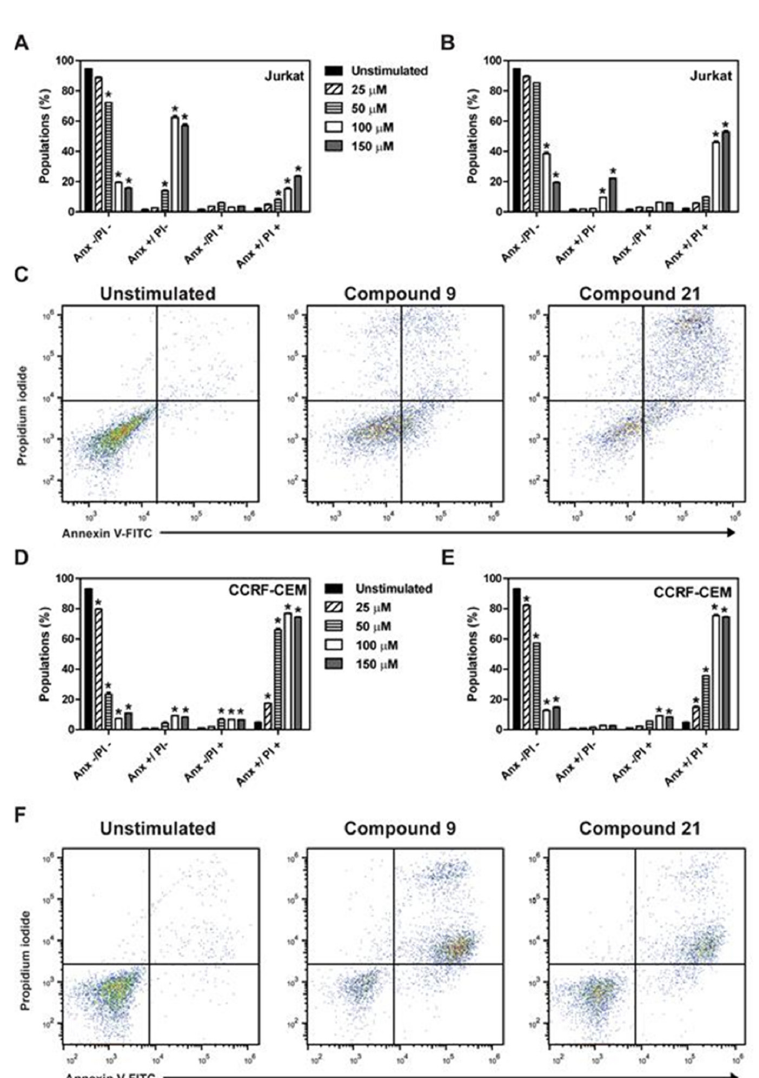
Figure 3. C9 and C21 compounds promoted cell death through different mechanisms in Jurkat and CCRF ‐ CEM ALL lineages. Cells of Jurkat and CCRF ‐ CEM at 2 × 10 5 cells/mL were used. Cells were